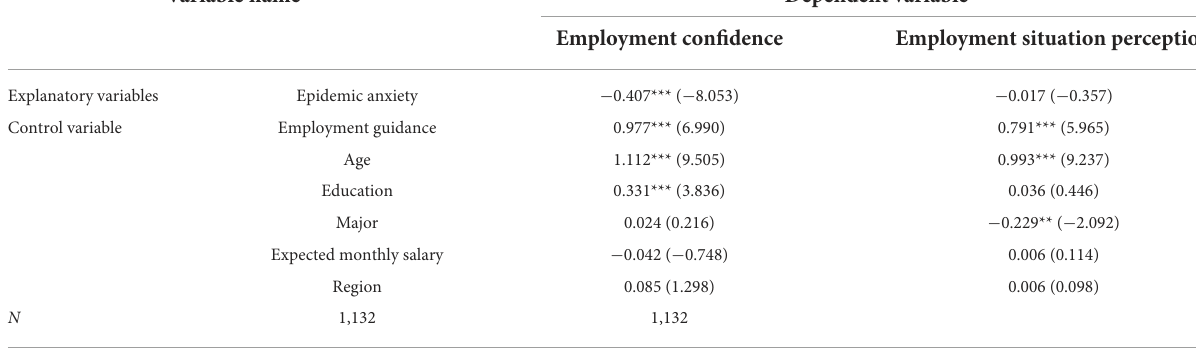
TABLE 3 Impact of epidemic anxiety on employment confidence and employment situation